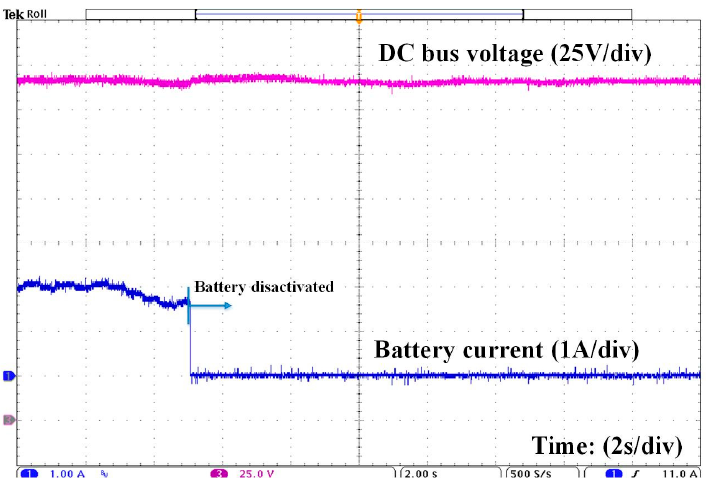
Figure 31. Start of the power supply to the battery bank (BB).